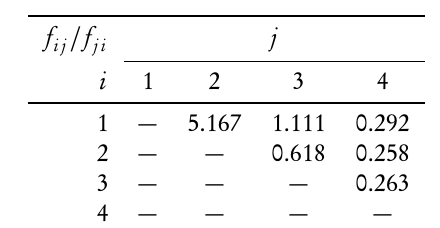
/ f for all i < j in Table ij ji